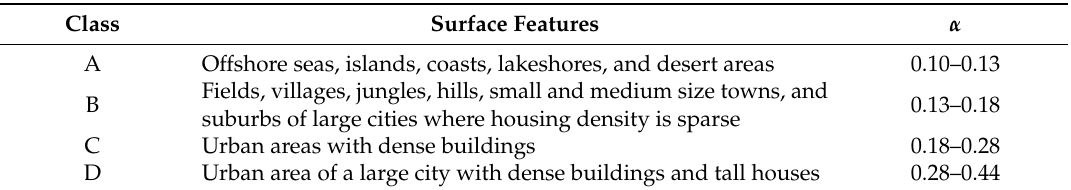
Table 1. Ground roughness